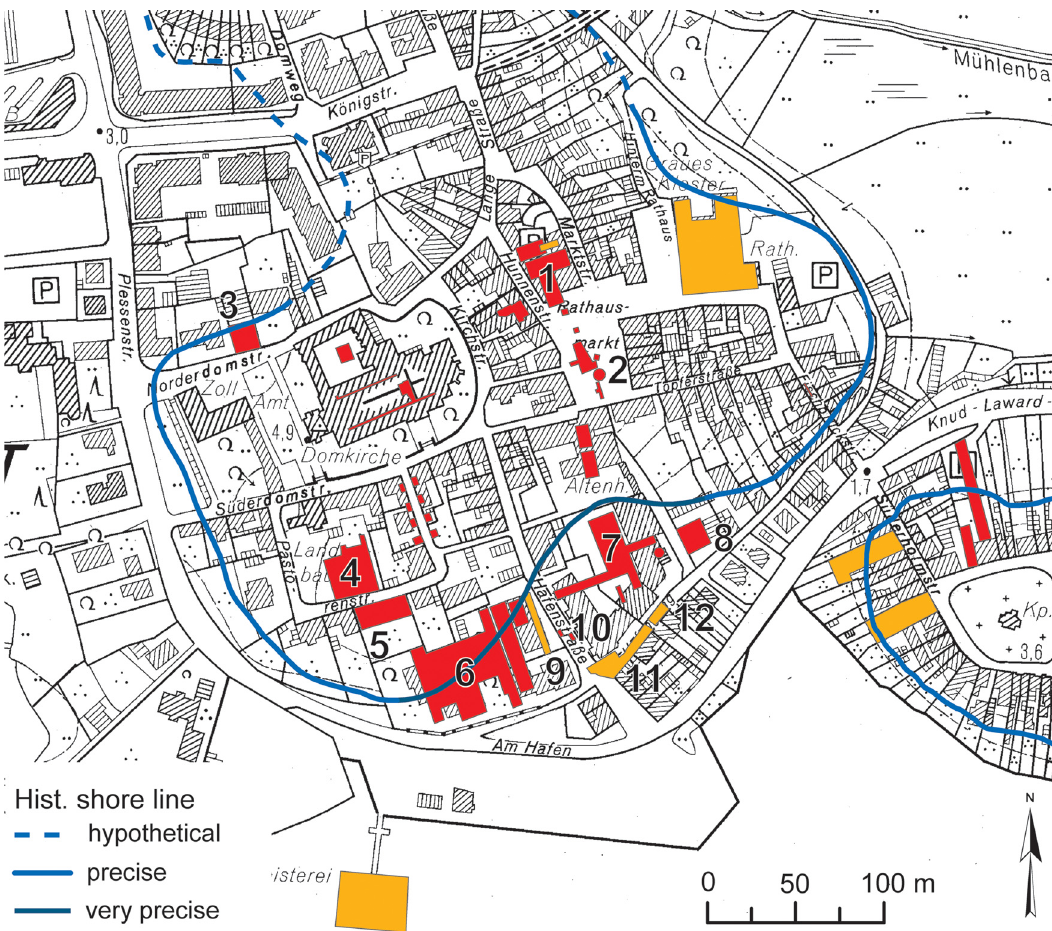
Figure 2: Schleswig old town. Excavations conducted until today ( red = excavated area known; orange = excavated area insecure ) . Nos. 1 – 5 designate various old town excavations, 6 – 12 designate the harbour excavations, and no. 6 is the Plessenstraße 83/3 ( Graphics: F. Rösch based on © GeoBasis - DE/LVermGeo SH ( www.LVermGeoSH.schleswig - holstein.de ) ATKIS®Basis - DLM 2013, DTK 5 )